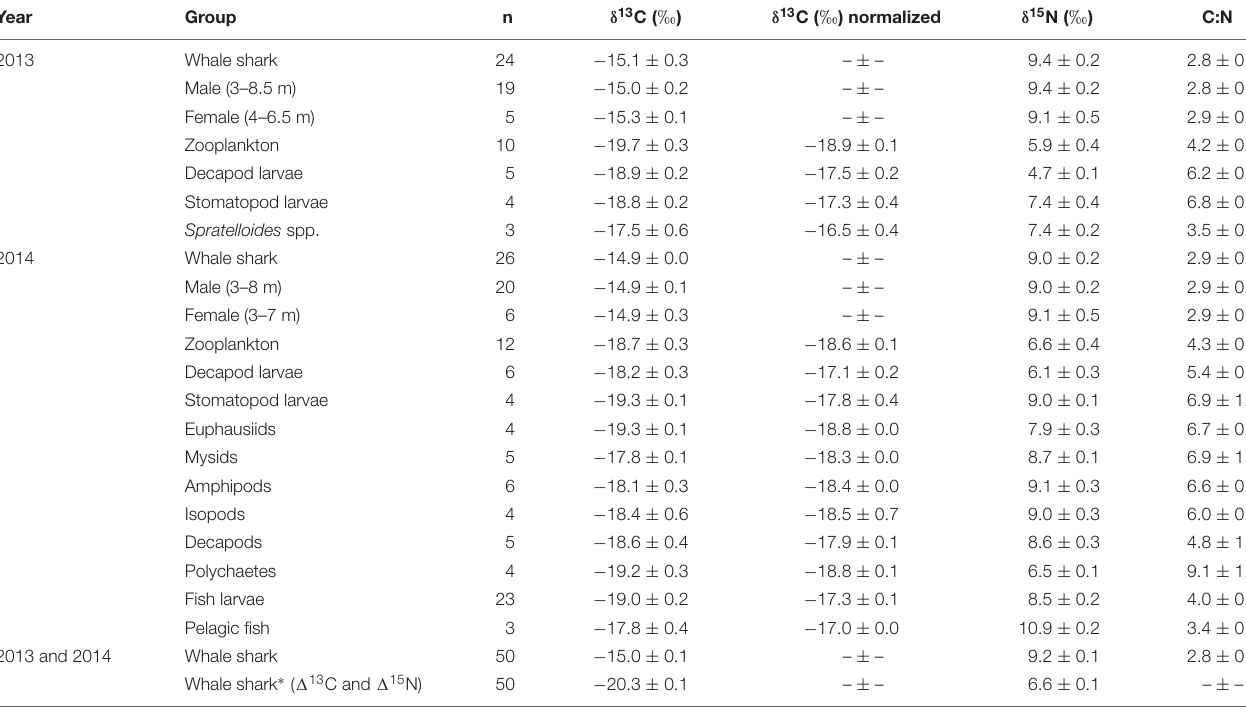
TABLE 1 | The mean isotopic values (